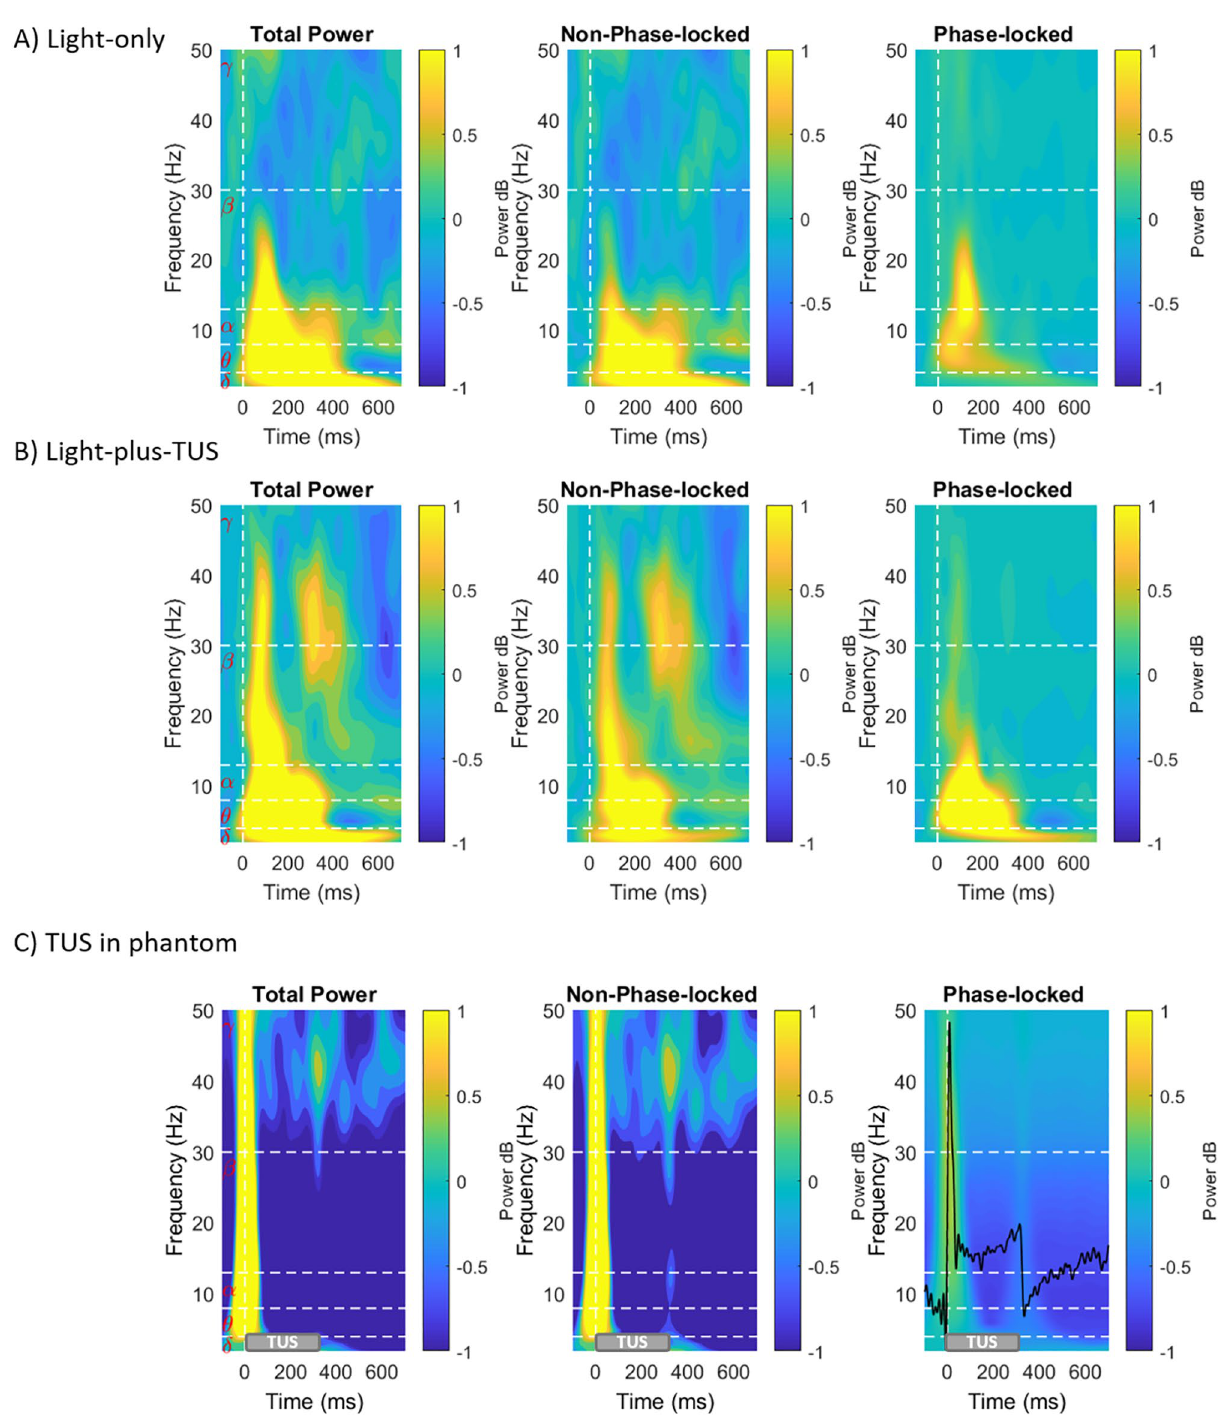
Figure 5. Effect of LGN TUS on Non-phase-locked and Phase-locked visual evoked cortical oscillations and EEG spectra of phantom experiments. Average (N = 5) EEG power spectra for Total Power, NPL Power, and PL Power (Columns) for two experimental conditions (Rows) ( A ) Light-only and ( B ) Light and TUS simultaneously; and ( C ) phantom experiments. Comparing Panel A with B shows the application of TUS at the LGN induces oscillations in the occipital cortex for the upper beta and gamma-band frequencies at approximately 90 and 280 ms post-stimulus. There is also a light PL activation in lower frequencies spread across theta and alpha bands. ( C ) The phantom was sonicated with 300 ms bursts at 1 Hz, while recording electrical activity (N = 5). The time domain signal plotted on top of the spectrum (black line); the gray bar shows 300 ms TUS duration. The frequency regions that differ significantly are shown in Fig.